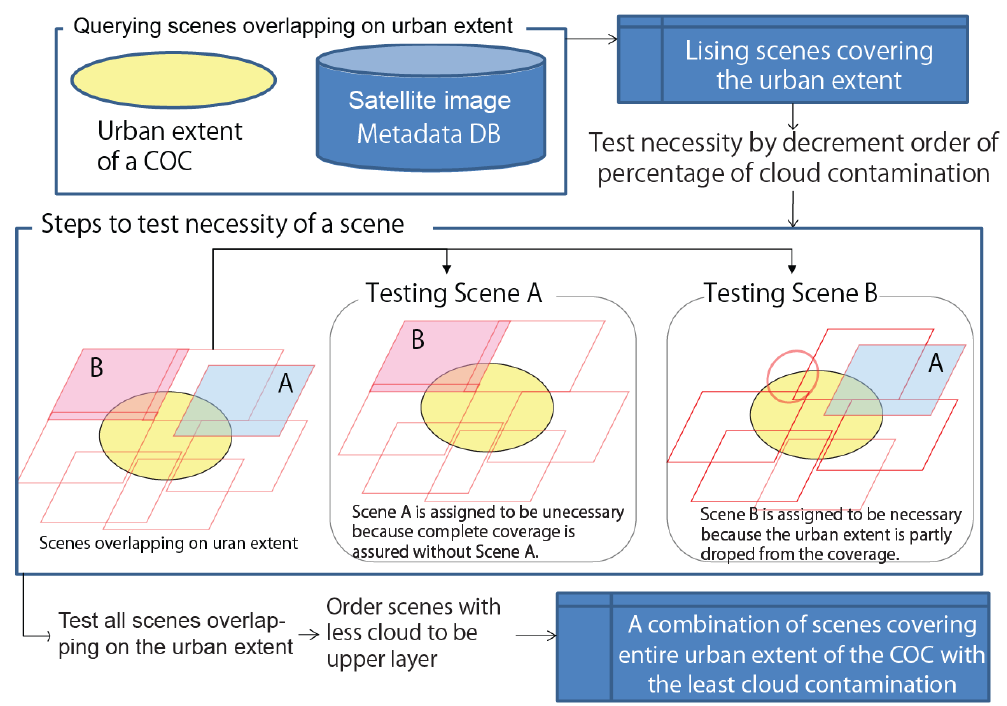
Figure 1. Steps to test necessity of scenes overlapping on urban extent of a crowd of